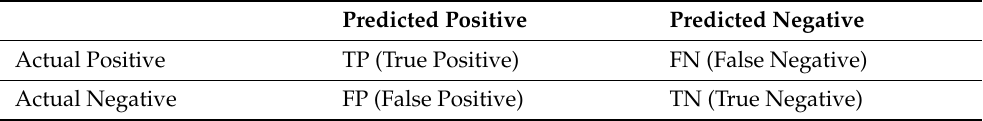
Table 2. Confusion matrix for the two-class classification